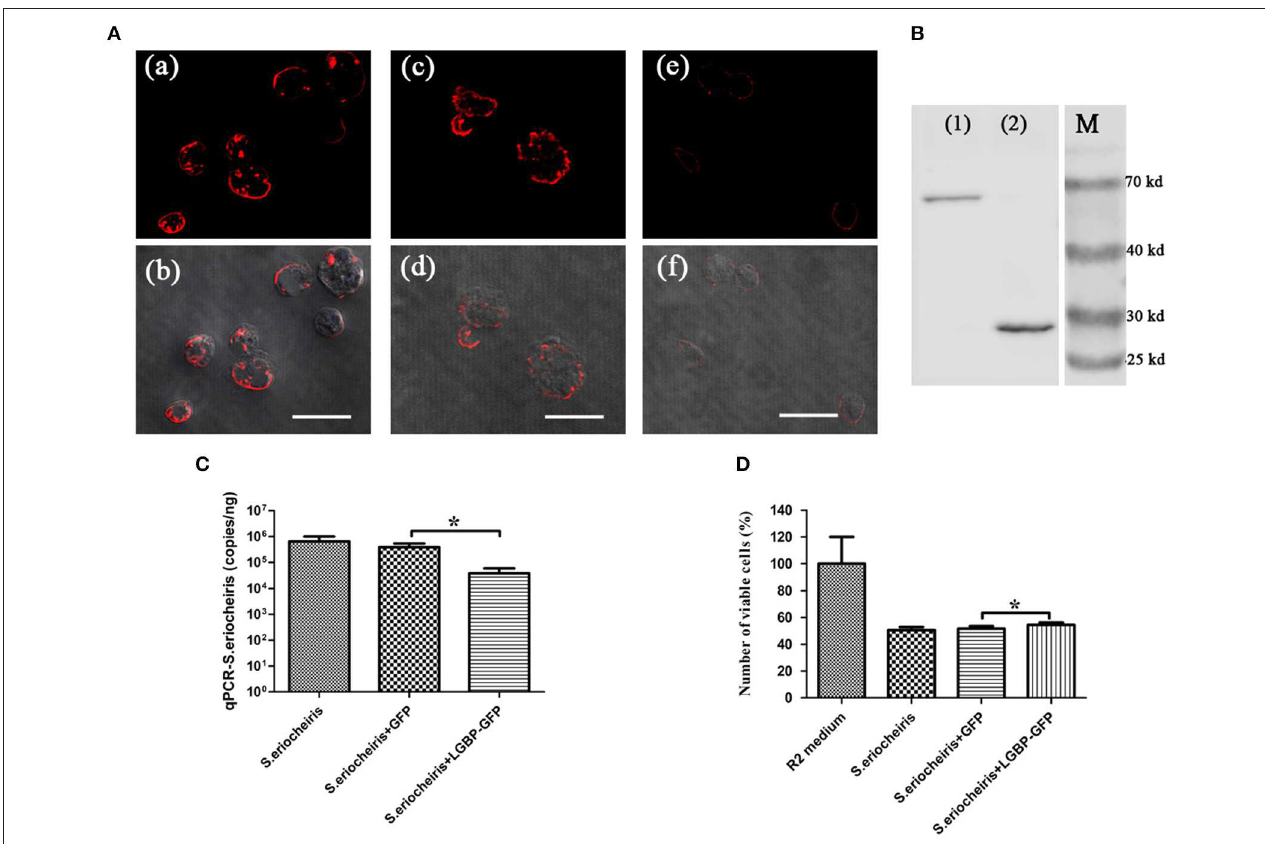
FIGURE 6 | Overexpression of MrLGBP promote Drosophila S2 cells to resist S. eriocheiris infection. (A) Immunocytochemistry analysis S. eriocheiris quantity in Drosophila S2 cells. Drosophila S2 cells were transfected with pAc5.1-MrLGBP-GFP or pAc5.1-GFP plasmids. Drosophila S2 cells were infected with S. eriocheiris for 48h. Then, the cells were incubated with anti- S. eriocheiris (primary antibody) and PE-labeled Goat anti-Rabbit IgG (second antibody, red), and examined using a confocal laser scanning microscope. (a,b) Represent the S. eriocheiris only group: (a), red fluorescence only, (b), the bright field merge with red fluorescence, (c,d) represents the S. eriocheiris + GFP group: (c), red fluorescence only, (d), bright field merge with red fluorescence, (e,f), represent the S. eriocheiris + LGBP-GFP group: (e), red fluorescence only, (f), bright field merge with red fluorescence, Bars, 10 µ m. (B) Western blot of MrLGBP expression in Drosophila S2 cells. Drosophila S2 cells were transfected with pAc5.1-MrLGBP-GFP or pAc5.1-GFP plasmids. Efficiency of MrLGBP overexpression in Drosophila S2 cells, as detected by western blotting with anti-GFP antibody. (1), experimental group; (2), control group; (M), protein marker. Approximate molecular sizes: MrLGBP, ∼ 68 kDa; GFP, ∼ 28 kDa. (C) Real-time PCR analysis of copy number for S. eriocheiris in Drosophila S2 cells. Drosophila S2 cells were transfected with pAc5.1-MrLGBP-GFP or pAc5.1-GFP plasmids. Drosophila S2 cells were infected with S. eriocheiris for 48h. S. eriocheiris quantity in Drosophila S2 cells. Vertical bars depict the mean ± S.E ( n = 9). (D) Cell viability by CCK-8 assay. Drosophila S2 cells were transfected with pAc5.1-MrLGBP-GFP or pAc5.1-GFP plasmids. Drosophila S2 cells were infected with S. eriocheiris for 48h. Relative cell viability was tested using CCK-8 assay. Cells used for different treatments are shown on the abscissa and relative cell viability rate on the ordinate. The assay was repeated three times. Vertical bars depict the mean ± S.E ( n = 36). Significant difference * p <